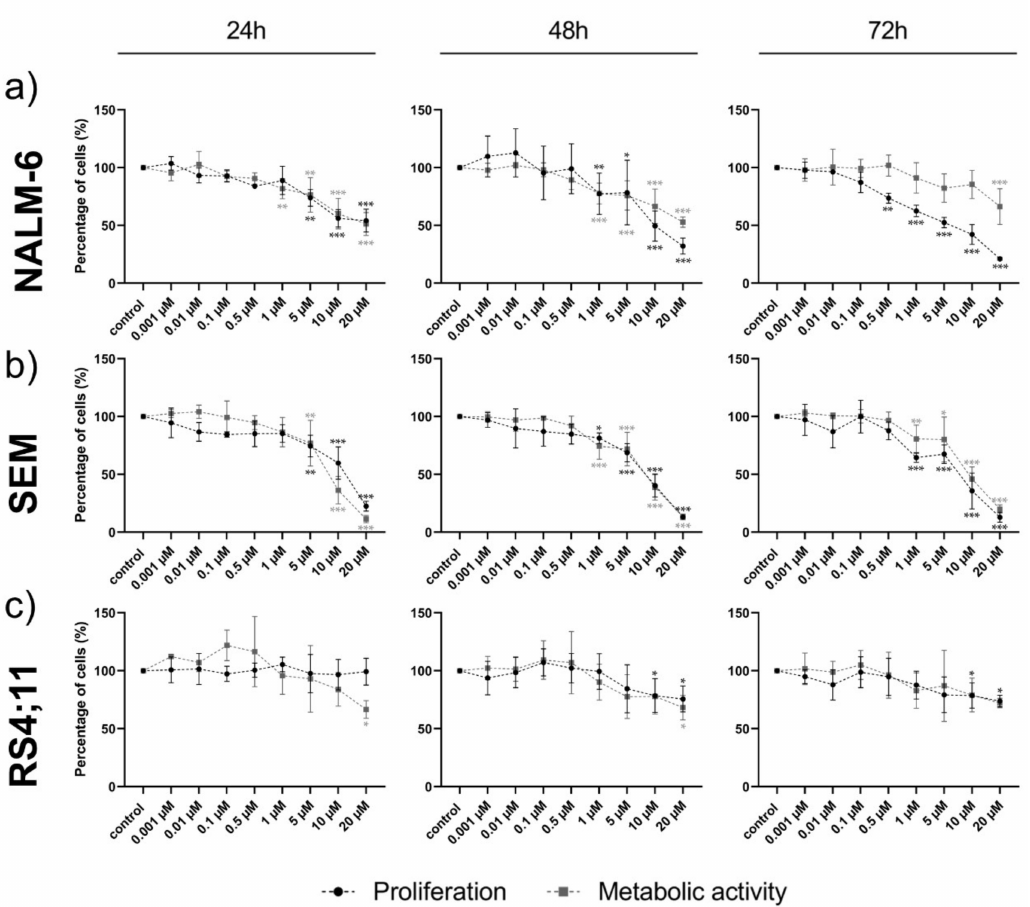
Figure 3. Cell viability after entospletinib exposure in B-ALL cell lines. Time- and concentration-dependent reduction in cell proliferation and metabolic activity in the pre-B-ALL cell line NALM-6 and pro-B-ALL cell lines SEM and RS4;11 by entospletinib. Cell proliferation and metabolic activity for entospletinib serially diluted at different concentrations (0.001 µ M–20 µ M) for 24 h, 48 h and 72 h ( a ) NALM-6, ( b ) SEM and ( c ) RS4;11. Data are presented as the mean ± SD. Statistical significance was calculated by one-way ANOVA followed by Dunnett’s multiple comparison test as a post-hoc analysis and displayed as * p < 0.033, ** p < 0.002, *** p < 0.001 versus the control group ( n ≥